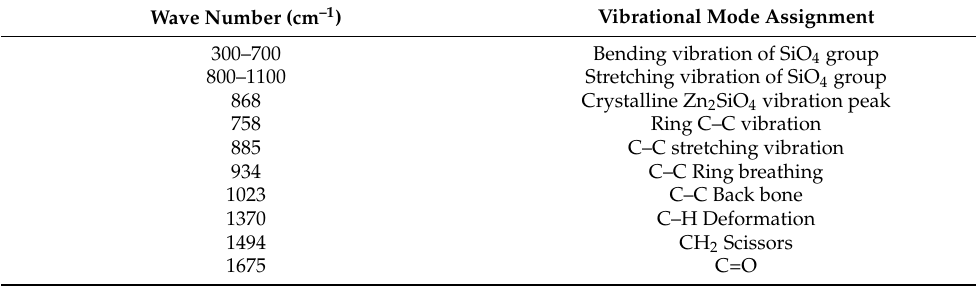
Table 3. Assignment and interpretation of the Raman absorption